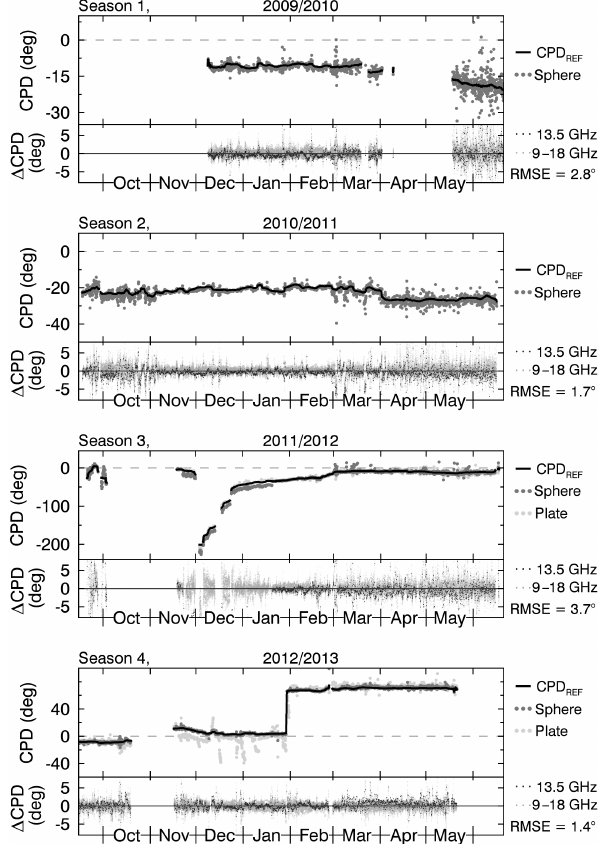
Figure D1. The CPD was calibrated using the sphere as a ref- erence target. The upper panels show the reference, CPD REF (f ) , for f = 13.5GHz (solid line) together with individual CPD mea- surements for the sphere and the plate (light and dark gray bul- lets). The CPD of the metallic plate agrees within the standard deviation with measurements of the sphere and with CPD REF . Deviations were found for season 3 due to misalignment of the SSI to the sphere and for November 2012 due possibly to snow cover of the metallic plate. The lower panels show the devi- ation, (cid:49) CPD = CPD meas. (f ) − CPD REF (f ) , for individual mea- surements at all measured frequencies f = 10 ... 17GHz. The de- viation for f = 13.5GHz is shown as black dots. The standard devi- ation (RMSE) of (cid:49) CPD for the whole frequency spectrum is given below the legend of the lower